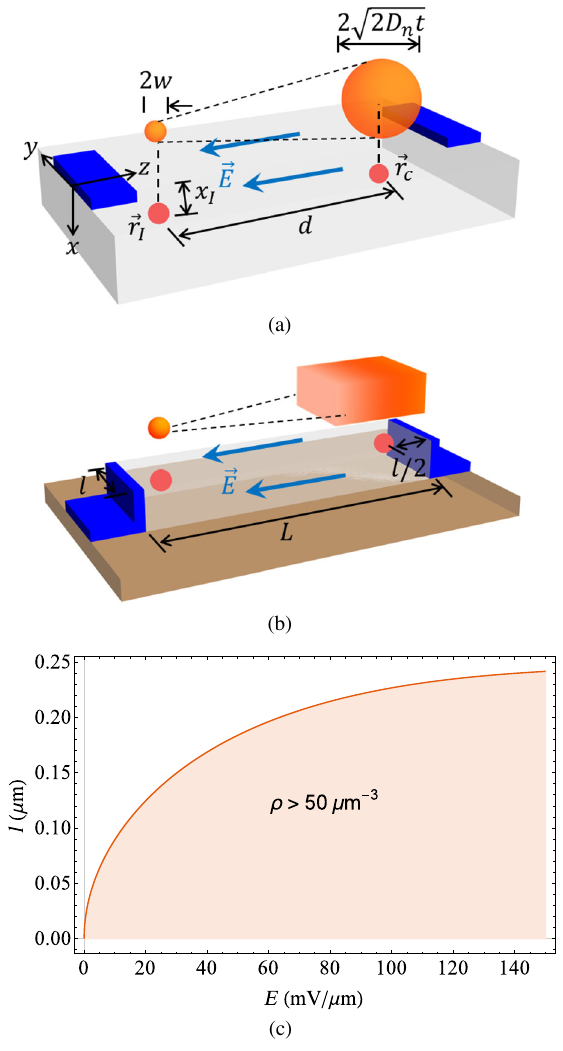
FIG. 3. (a) A simple transport architecture consisting of two surface electrodes (dark blue) on bulk diamond (gray). (b) Exam- ple architecture for transport via a nanowire (gray) on top of a substrate (brown) with end electrodes (dark blue). In (a) and (b), the ionizing and capture centers are depicted as red spheres and the initial and final electron probability densities are depicted above in orange. All other labels are as described in the text. (c) The shaded region defines the nanowire dimension l and applied electric field E where the electron probability density at the capture center is the required ρ > 50 μ m − 3 to yield a capture time < 100